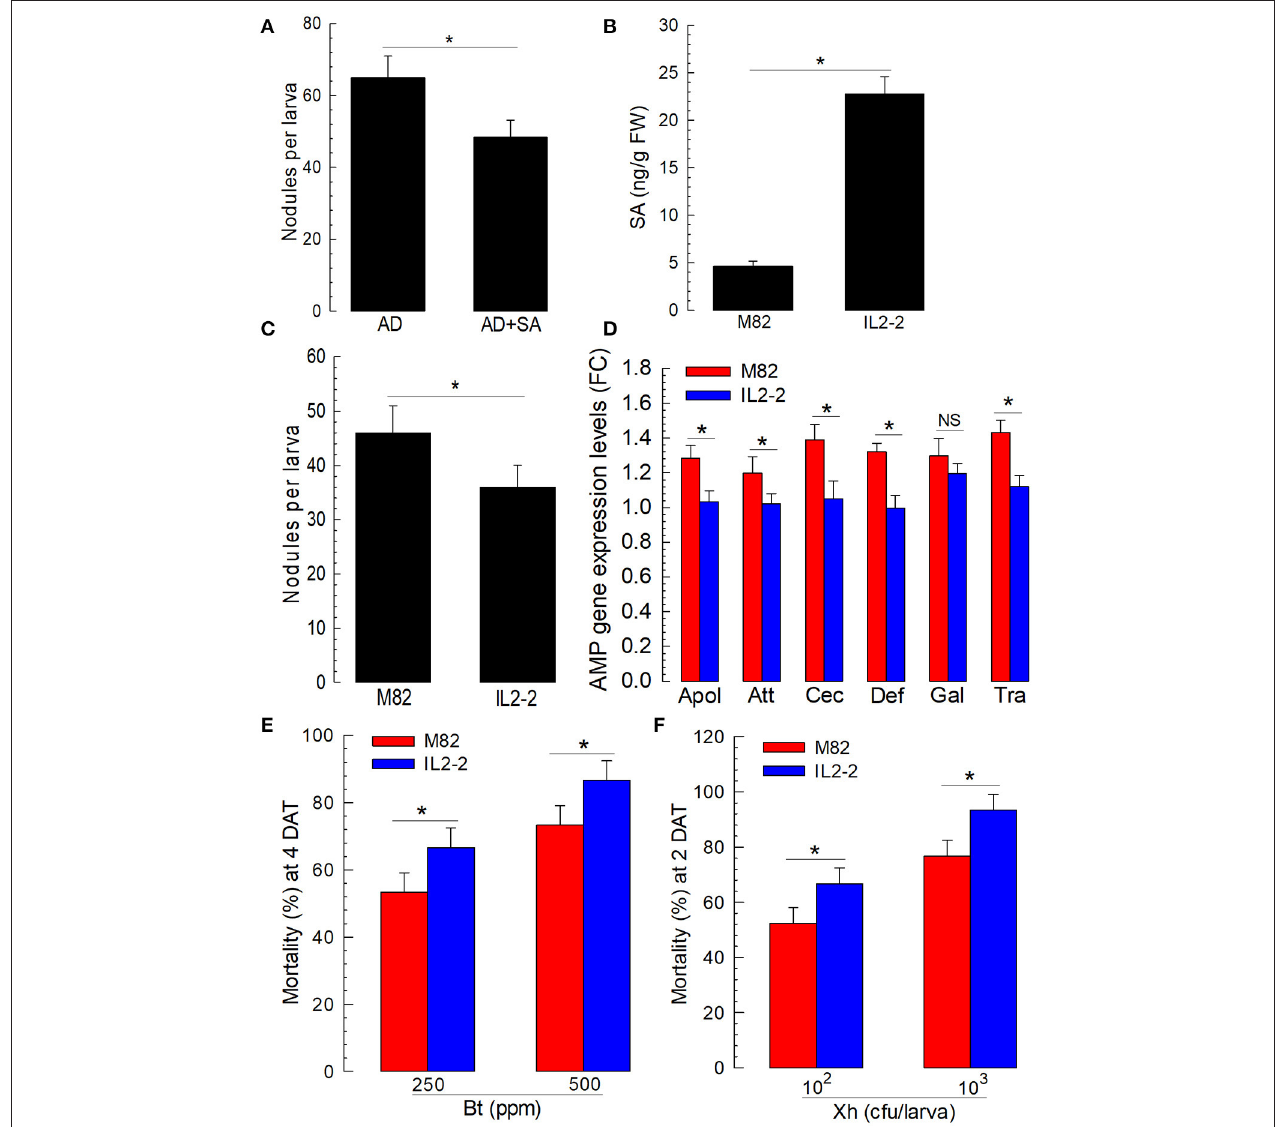
FIGURE 7 | Influence of different tomato varieties on the immune responses and susceptibilities of S. exigua larvae to entomopathogens. (A) The suppression of cellular immune response by the addition of SA to artificial diet (“AD + SA”). AD was dipped in 1,000 ppm of the SA solution and used to feed L5 larvae for 3 days. The control diet (AD) was treated with dimethyl sulfoxide (DMSO). To assess cellular immune response, hemocyte nodule formation was determined after injecting HK E. coli at 4.5 × 10 4 cells per larva. Nodule formation was assessed 8h after the E. coli injection. (B) SA contents in M82 and IL2-2 ( n = 5). (C) The suppression of nodulation with a high SA line, IL2-2. (D) The suppression of humoral immune response with a high SA line, IL2-2. For the assessment of humoral immune response, HK E. coli (4.5 × 10 4 cells per larva) were injected. After 6h, fat bodies were collected and used to assess the expression levels of six AMP genes: apolipophorin III (“Apol”), attacin 1 (“Att”), cecropin (“Cec”), defensin I (“Def”), gallerimycin (“Gal”), and transferrin I (“Tra”). A ribosomal protein, RL32 , was used as an internal control. Each treatment was replicated three times. (E,F) The influence of M82 and IL2-2 on the susceptibility of S. exigua larvae to entomopathogens of Bt and Xh. To determine pathogenicity, a feeding assay was performed for Bt, while a hemocoelic injection was performed for Xh. Each treatment was replicated three times. For each replication, 10 L2 larvae were used. Asterisks indicate a significant difference between control and treatment at Type I error = 0.05 (LSD